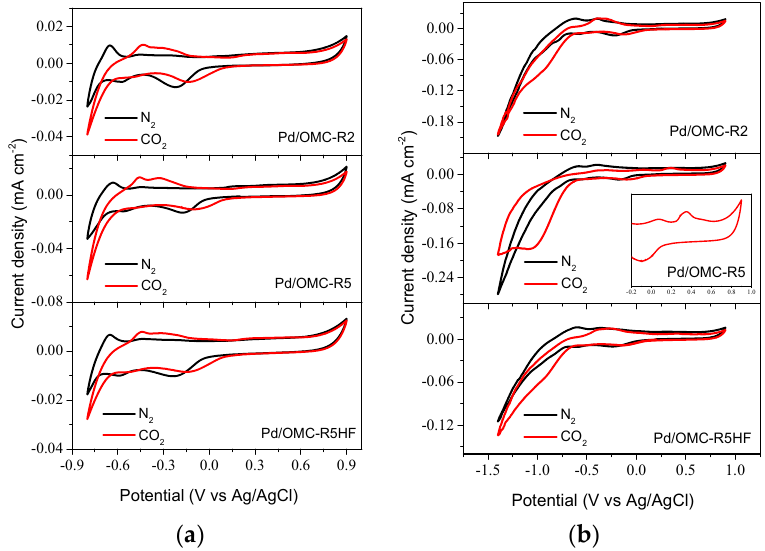
Figure 5. Cyclic voltammograms (CVs) of Pd/C catalysts in 0.1 M KHCO 3 (v = 10 mV s −1 , E i = 0.2 V vs. Ag/AgCl): ( a ) from −0.8 to 0.9 V vs. Ag/AgCl; ( b ) from −1.4 to 0.9 V vs. Ag/AgCl. N 2 saturated solution. Red curves: CO 2 saturated solution.